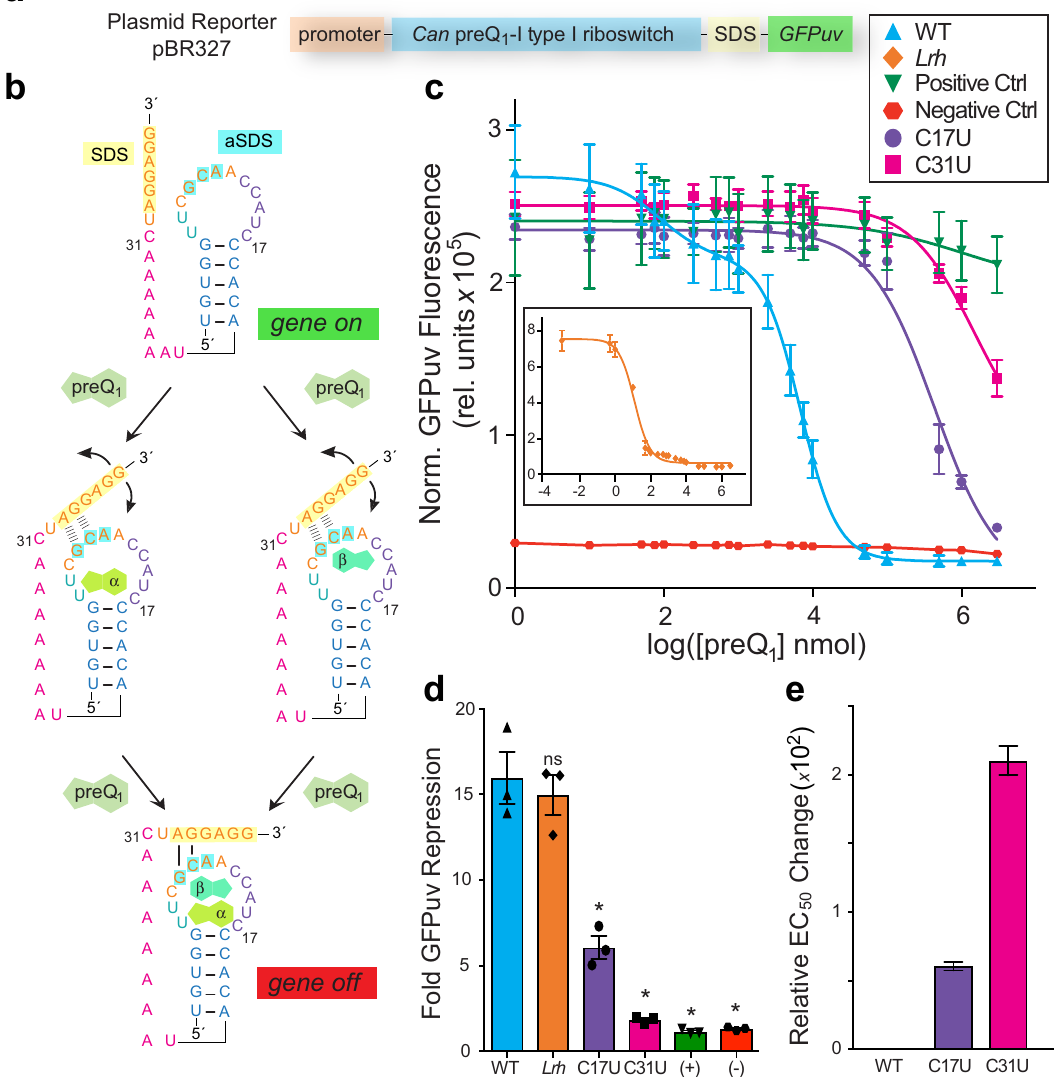
Fig. 3 Riboswitch reporter assay and dose response in live bacteria. a Schematic of the plasmid reporter. b Two-site binding model wherein preQ 1 can bind either site fi rst. c Average GFP uv emission dependence on preQ 1 ; ( inset ) one-site binding by the Lrh preQ 1 riboswitch 38 . d Bar graph showing fold repression of GFP uv emission for the Can, Lrh and mutant riboswitches with individual points shown. e Bar graph showing fold change in average EC 50 relative to Can riboswitch EC 50,2 . Signi fi cance was determined by a two-tailed Student ’ s t test with Welch ’ s Correction ( n = 3 biological replicates. * p ≤ 0.05). S.E.M. is shown in c and d ; propagated errors are shown in e